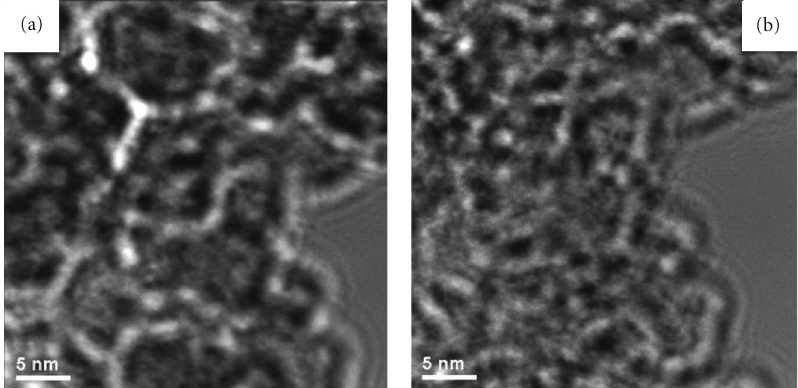
Figure 7: TEM image of T20Z-400 sample, presenting the obtained mesoporous with a “worm like structure” (a) underfocus image and (b) overfocus image.